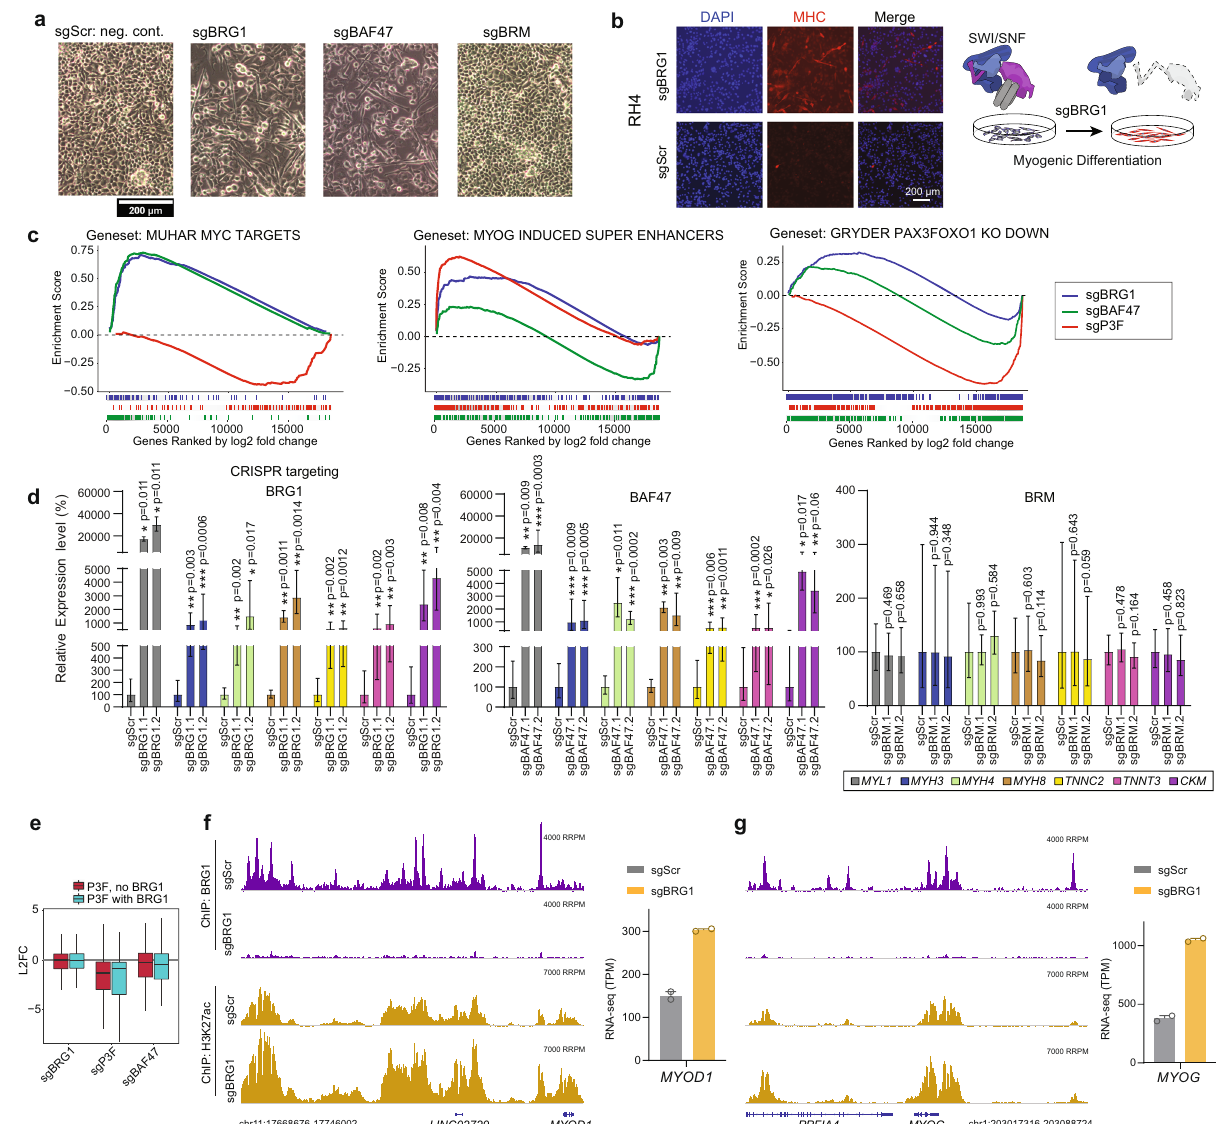
Fig. 3 BAF complexes mediate myogenic differentiation blockade in FP-RMS. a Phase contrast images for morphology in Cas9 expressing RH4 cells 7 days after transduction with indicated sgRNAs with inset scalebar. b Immuno fl uorescence staining for DAPI (left panel), Myosin heavy chain (middle panel), or merged images (right panel) for either BRG1 knockout cells (top) or control cells (bottom) 7 days after transduction. c GSEA analysis of RNA-seq experiments of Cas9 expressing RH4 cells transduced with either guide RNAs against BRG1, BAF47, or PAX3-FOXO1 compared to negative control 7 days after transduction. d Relative mRNA expression levels of muscle differentiation marker genes 7 days after transduction of Cas9 expressing RH4 cells with indicated sgRNAs measured by quantitative real-time PCR. Ct values relative to negative control sgRNA transduced cells were normalized to GAPDH expression. Mean and error bars indicating upper and lower limit values are indicated for at least three independent biological replicates. Statistical signi fi cance (based on dCt values) is given compared to negative control by paired t -tests (two-tailed). e Differential expression levels of genes bound by PAX3-FOXO1 according to presence or absence of mSWI/SNF complex co-occupancy. Box plots of median and quartiles, with whiskers showing 1.5 × inter-quartile ranges. f , g Genome browser tracks showing MYOD1 and MYOG loci for Spike-in normalized ChIP-seq experiments performed in